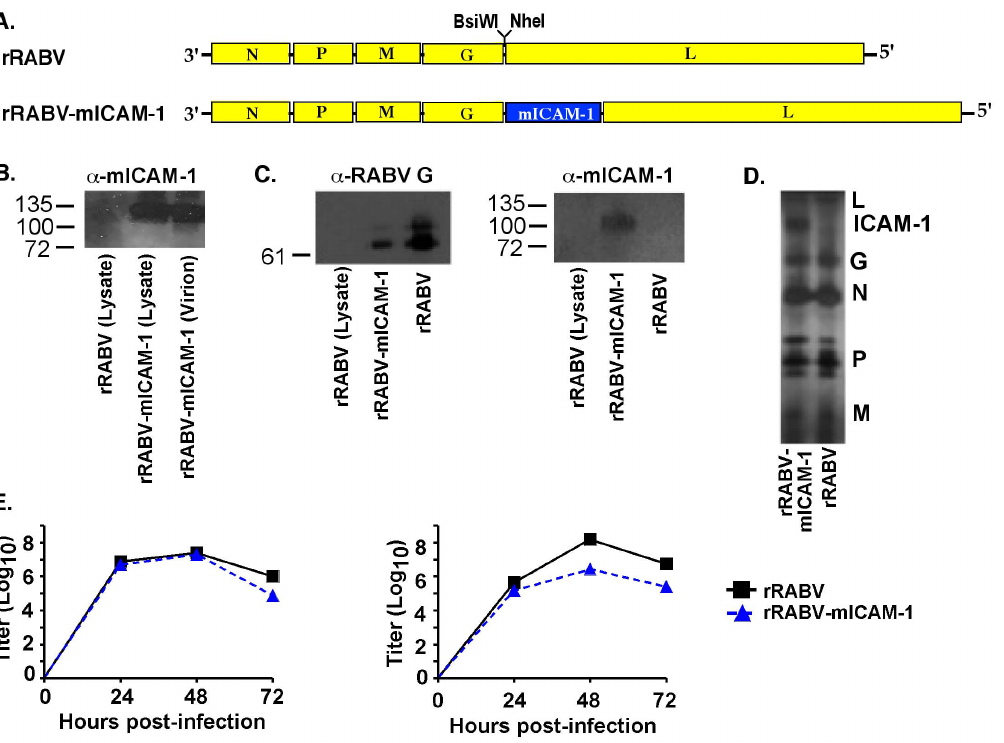
Figure 1. Construction, recovery and characterization of a recombinant RABV-based vaccine expressing the murine Icam1 gene (rRABV-mICAM-1). A) At the top is a parental recombinant RABV-based vaccine containing an additional transcription stop-start signal flanked by two unique restriction sites between the G and the L genes. rRABV, which is a molecular clone of the SAD-B19 vaccine strain of RABV, was the target to introduce the gene encoding murine ICAM-1. B) . BSR cells, which are not expected to express ICAM-1 or its binding partner LFA-1, were infected with rRABV or rRABV-mICAM-1 and lysed 48 hours later. Proteins were separated by SDS-PAGE and subjected to Western blotting with antibodies specific for ICAM-1. A protein of the expected size for ICAM-1 was detected from lysates of rRABV-mICAM-1-infected but not from rRABV-infected BSR cells. In parallel, sucrose-purified and concentrated virus was analyzed by western blot analysis and a protein of the expected size for ICAM-1 was detected in the virion particle. C) Sucrose-purified rRABV-mICAM-1 was re-purified using 5% sucrose step gradient and the single band was collected and analyzed by Western blot analysis to show ICAM-1 protein migrated within the sucrose gradient at the same density as rRABV. RABV and lysates from uninfected BSR cells served as controls for the Western blot analyses. D) Silver staining of separated proteins from sucrose step gradient-purified particles shows a protein at the expected size of ICAM-1 and that the incorporation of ICAM-1 into the virus particles does not affect viral protein compositions. E) BSR cells were infected with rRABV or rRABV-mICAM-1 at a MOI of 5 (one step growth; left) or .01 (multi-cycle growth curve; right). Aliquots of tissue culture supernatants were collected, and viral titers were determined in duplicate.